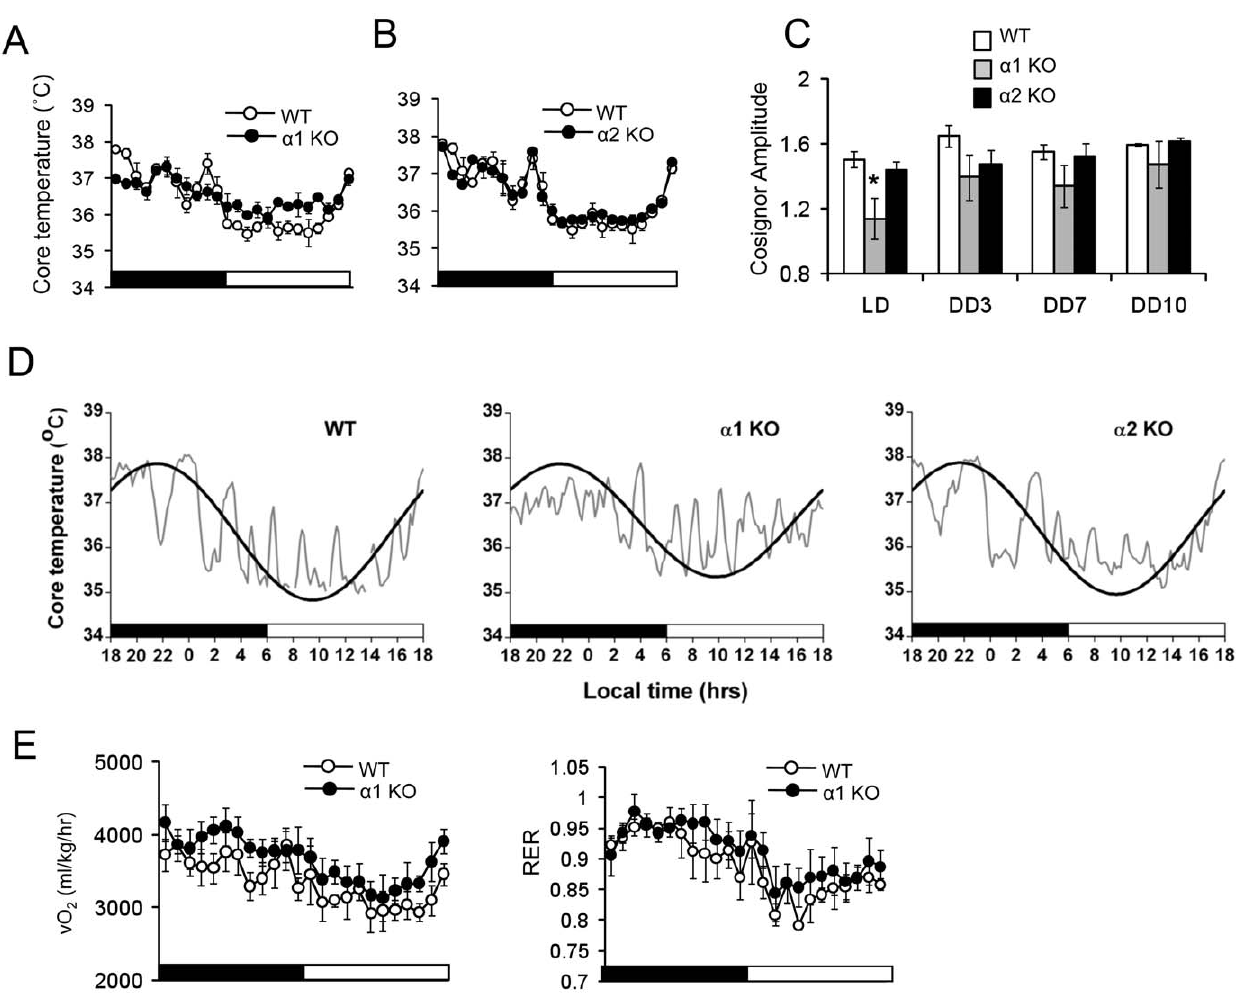
Figure 4. Disruption of circadian physiology in AMPK a -deficient mice. (A,B) Corebody temperature was measured by telemetry.AMPK a 1 2 / 2 , AMPK a 2 2 / 2 and WT mice were monitored in LD for 7 days followed by DD for 14 days. Representative data (mean 6 SE) is LD day 7. Lights on is indicated by a white bar and lights off is indicated by a black bar. The same WT data is plotted in A and B. (C) Amplitude calculated from cosinor analysis of WT, AMPK a 1 2 / 2 and AMPK a 2 2 / 2 micein LD,DDday 3,7, 10.Results are expressed as mean 6 S.E.* P , 0.05 between WT miceversus AMPK a 1 deficient mice (n=3–5 for each genotype). (D) Cosinor analysis of core temperature for WT, AMPK a 1 2 / 2 and AMPK a 2 2 / 2 mice. The cosine curve (black line) is superimposed on core temperature raw data (gray line). A representative plot is shown for each genotype (E) VO 2 (left) and RER (right) in AMPK a 1 2 / 2 and WT mice. Average data is shown under LD on day 7. Light on is indicated by a white bar and light off is indicated by a black bar (n=4 for each genotype).